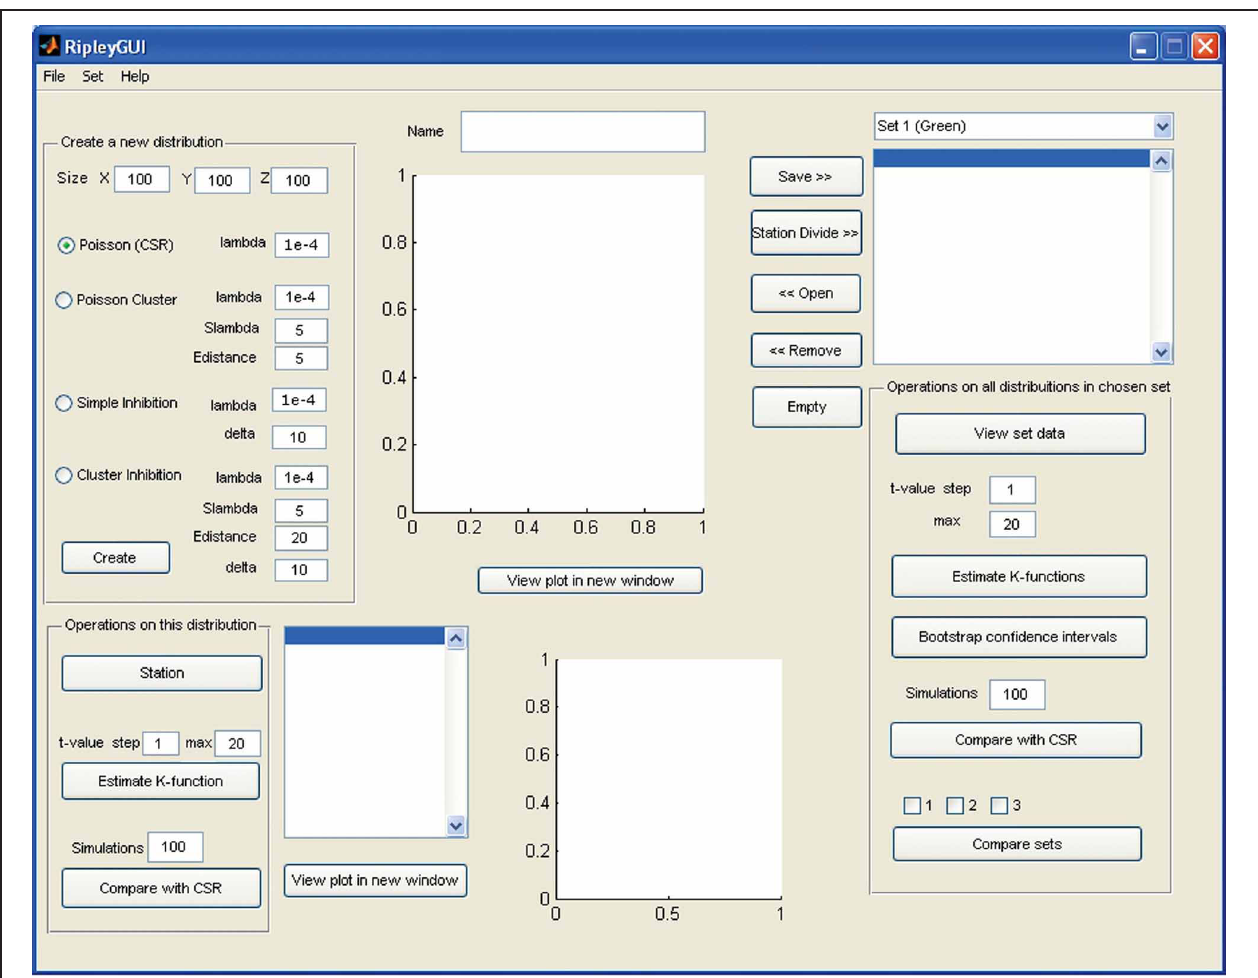
analysis of the distribution on display in the upper central panel (Name). The right panel (Operations on all distributions in a chosen set) is designed for saving, managing, and analyzing single or multiple data sets. The results of all the analysis can be viewed inside or outside of RipleyGUI depending on the user’s preference. All analysis-related parameters are tunable in their corresponding